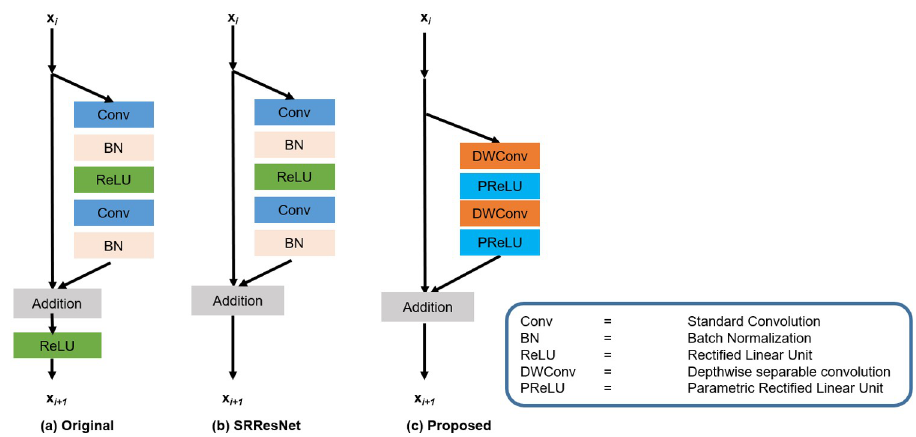
Fig 2. Comparison diagram of different ResNet blocks with the proposed ResNet block. (a) Original ResNet block. (b) SRResNet without final ReLU activation function. (c) Our Proposed ResNet block that removes the BN and replaces the regular convolution and ReLU activation function with depthwise separable convolution followed by the PReLU activation function.